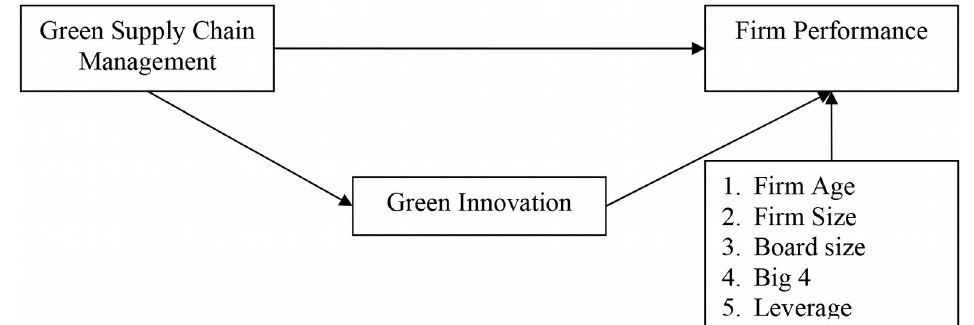
Figure 1. Conceptual research